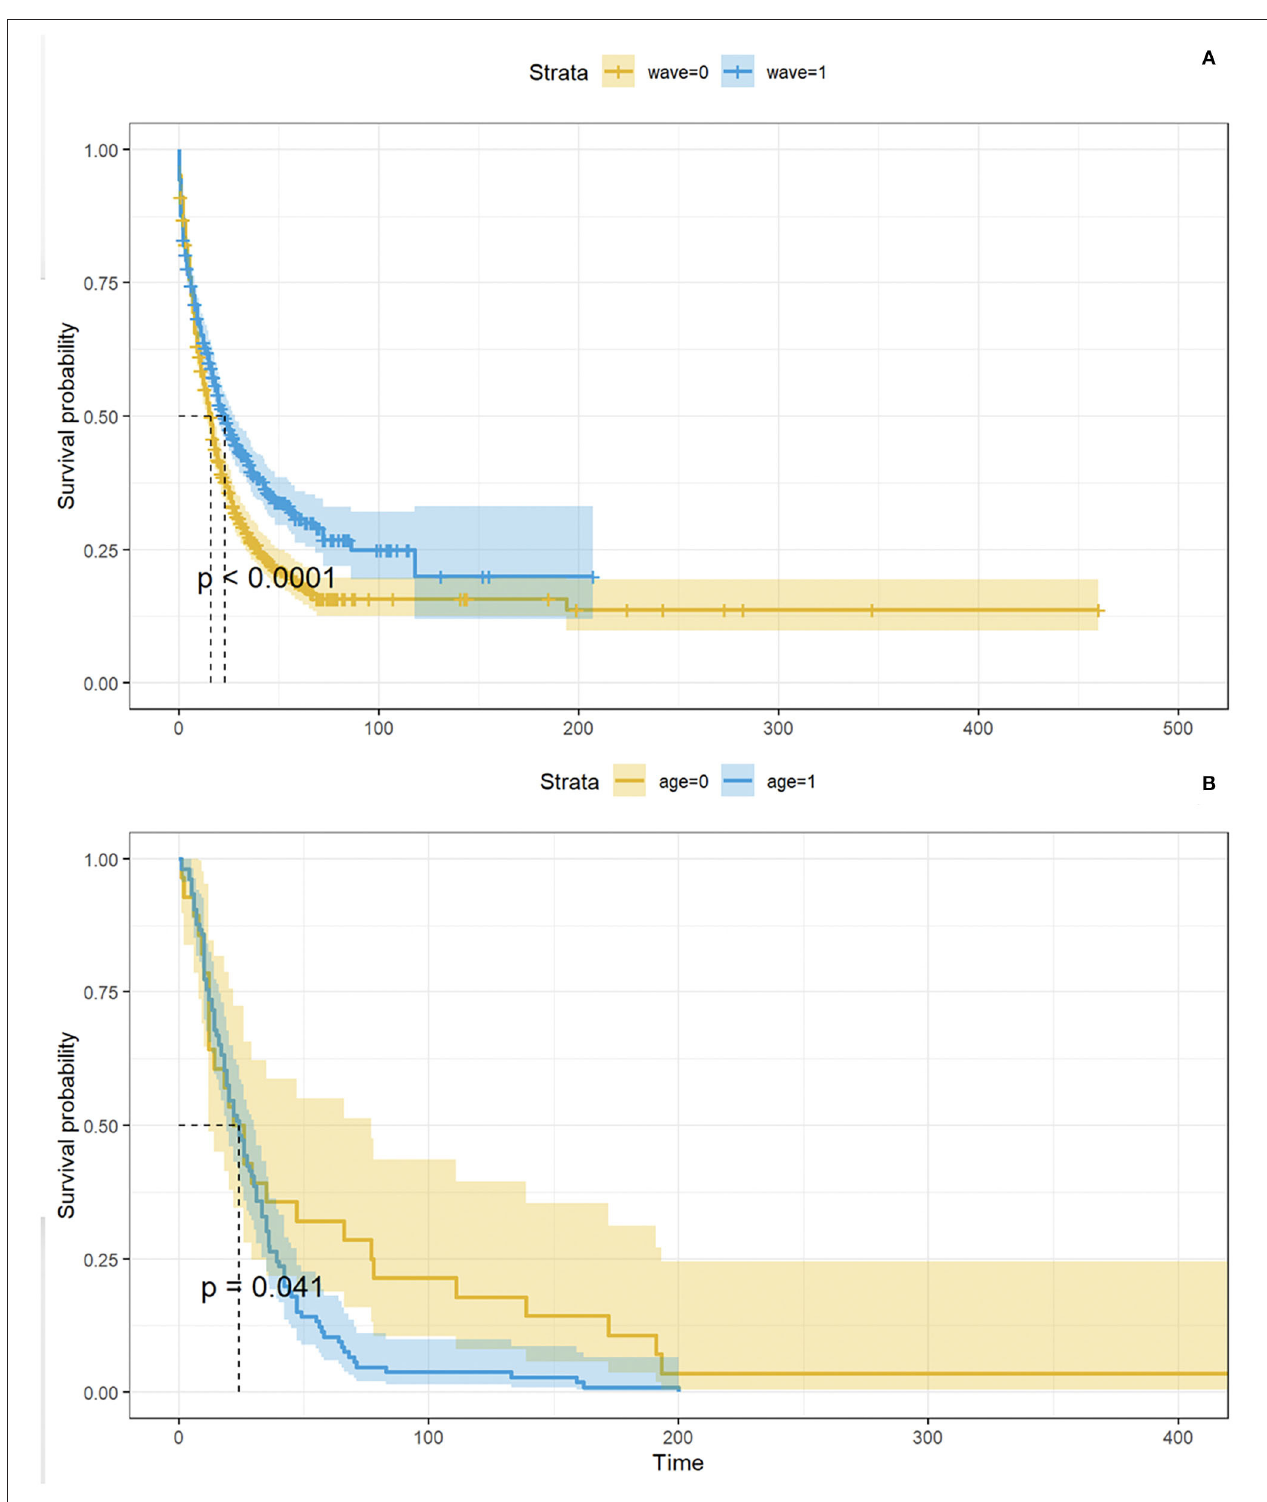
FIGURE 6 | In (A) , KM curves showing time between positive test and admission to the ICSM COVID-19 ward by wave. The p - value derives from the logrank test. In (B) , KM curves showing time between positive test and admission to the ICSM COVID-19 ward by age ( < 77 and ≥ 77 years). The p - value derives from the logrank